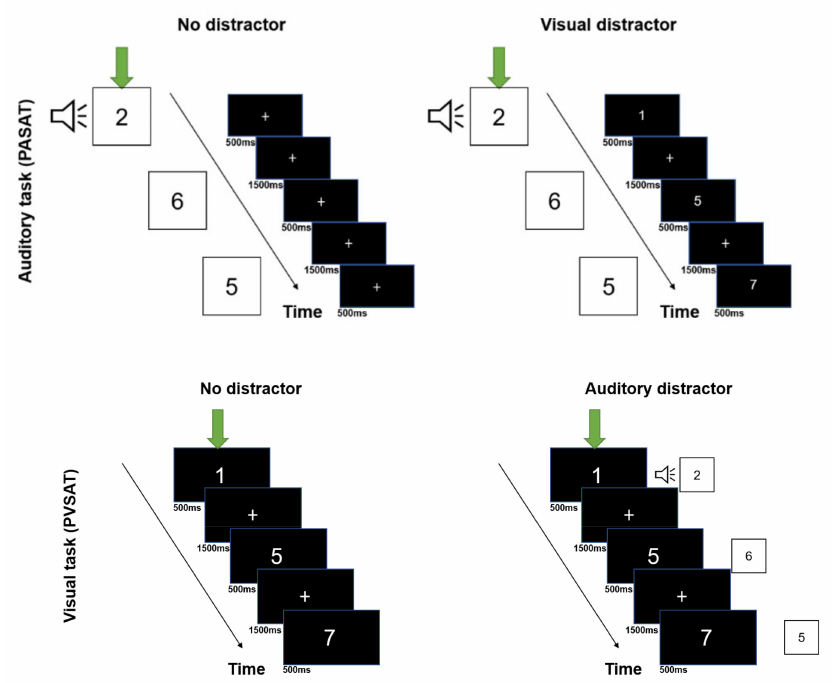
Figure 2. Experimental design. Experimental design of the Paced Auditory Serial Addition Test (top panel) and Paced Visual Serial Addition Test (bottom panel) without distractor (left side), with cross-modal distractors (right side). Green arrows indicate the target